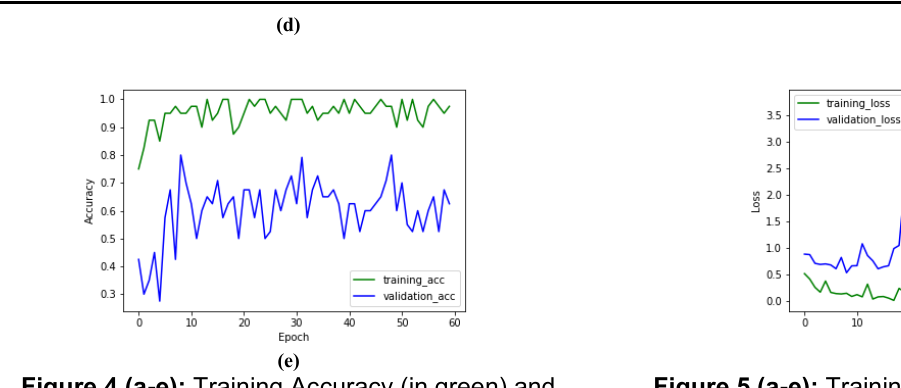
Figure 4 (a-e): Training Accuracy (in green) and Figure 5 (a-e): Training Loss (in green) and Validation Validation Accuracy (in blue) during the training of Loss (in blue) during the training of models (1), (2), (3), models (1), (2), (3), (4) and (5) for the categorization of (4) and (5) for the categorization of radiograph images. radiograph images.